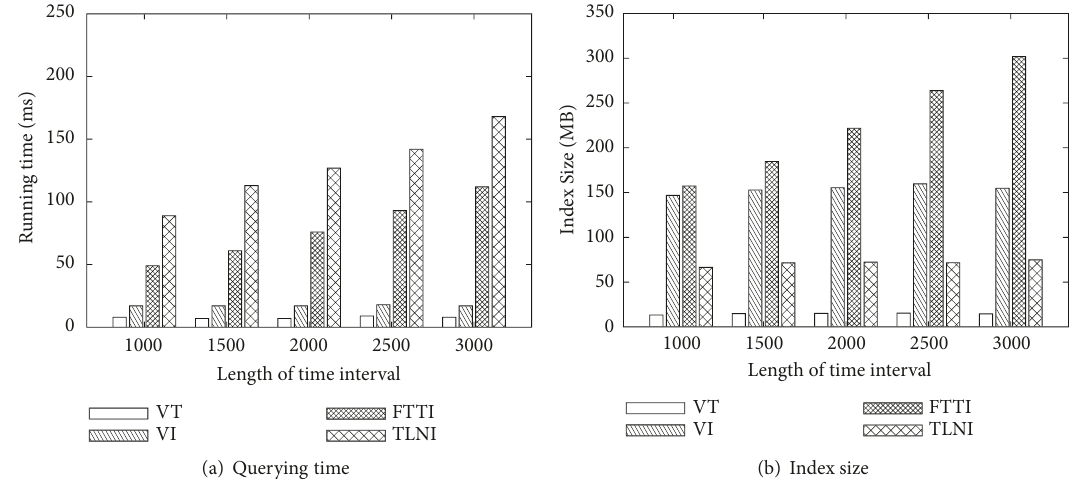
Figure 7: Impact of the length of time